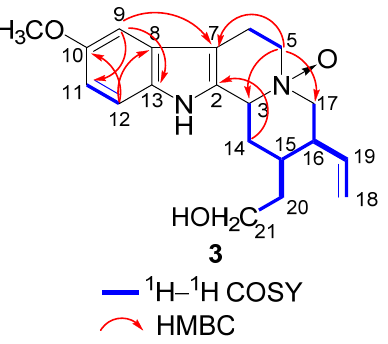
Figure 7. Key 1 H − 1 H COSY and HMBC correlations of 3 .